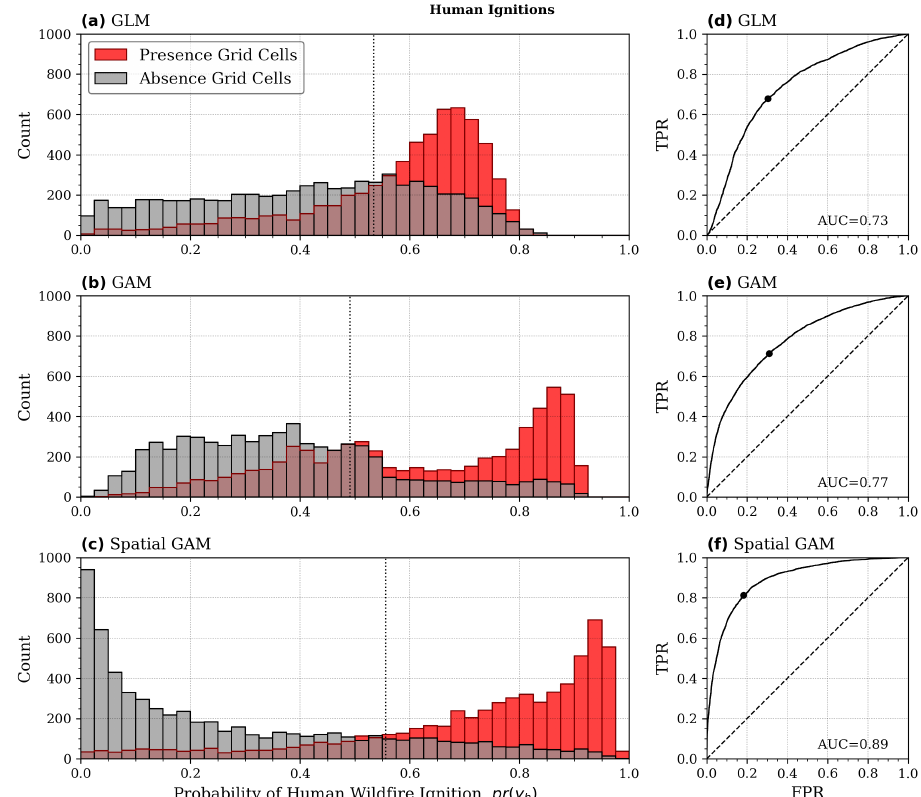
Figure 6. Evaluation of the multiple logistic general linear model (GLM), general additive model (GAM), and spatial-GAM used to model human-caused wildfire ignition probability. Model def- initions are shown in Table 1. Each model was applied to the held-back testing datasets and the frequency distributions shown in ( a – c ) indicate the count of presence (red) and absence (black) grid cells according to their predicted probability. The receiver operating characteristic (ROC) curves and area under the ROC curves (AUC) shown in ( d – f ) were also generated from the testing datasets. The optimum probability thresholds (i.e., closest to TPR = 1.0 and FPR = 0.0) are shown as dotted vertical lines in ( a – c ) and solid circles in ( d – f ).